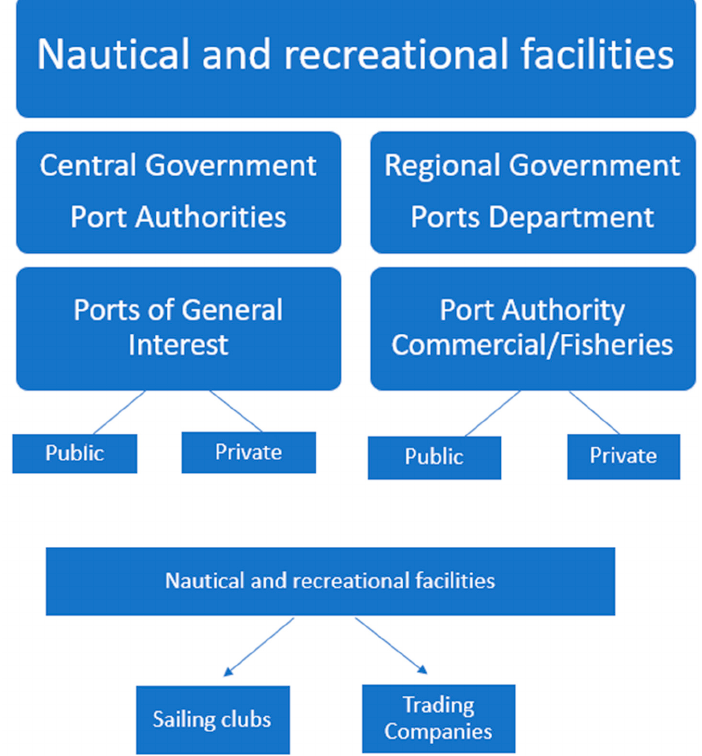
Figure 2. Types of management of nautical facilities. Source: FEAPDT, 2016.